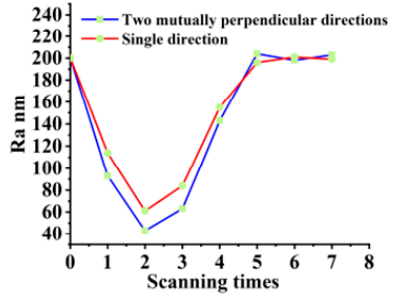
Figure 10. Curve of surface roughness with the change of scanning times in different